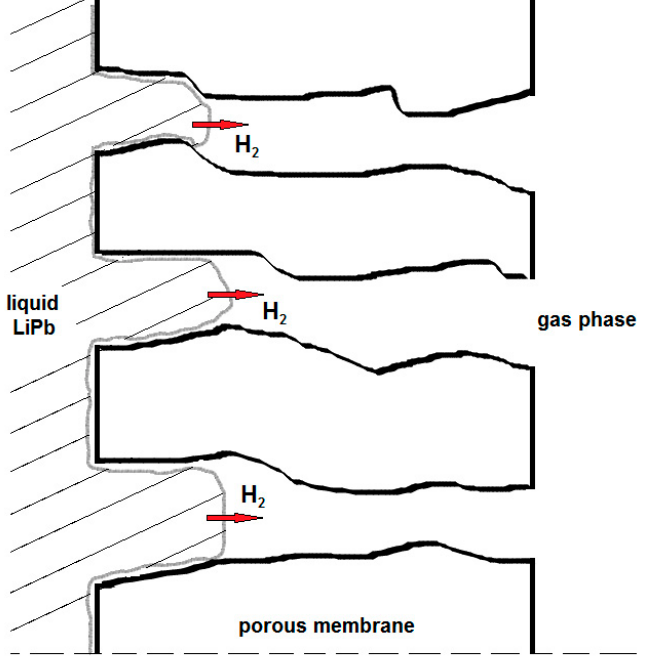
Figure 6. In the Membrane Gas–Liquid Contactor (MGLC) realized by porous membranes, the liquid LiPb partially penetrates the pores of the membrane without entering into the gas phase.